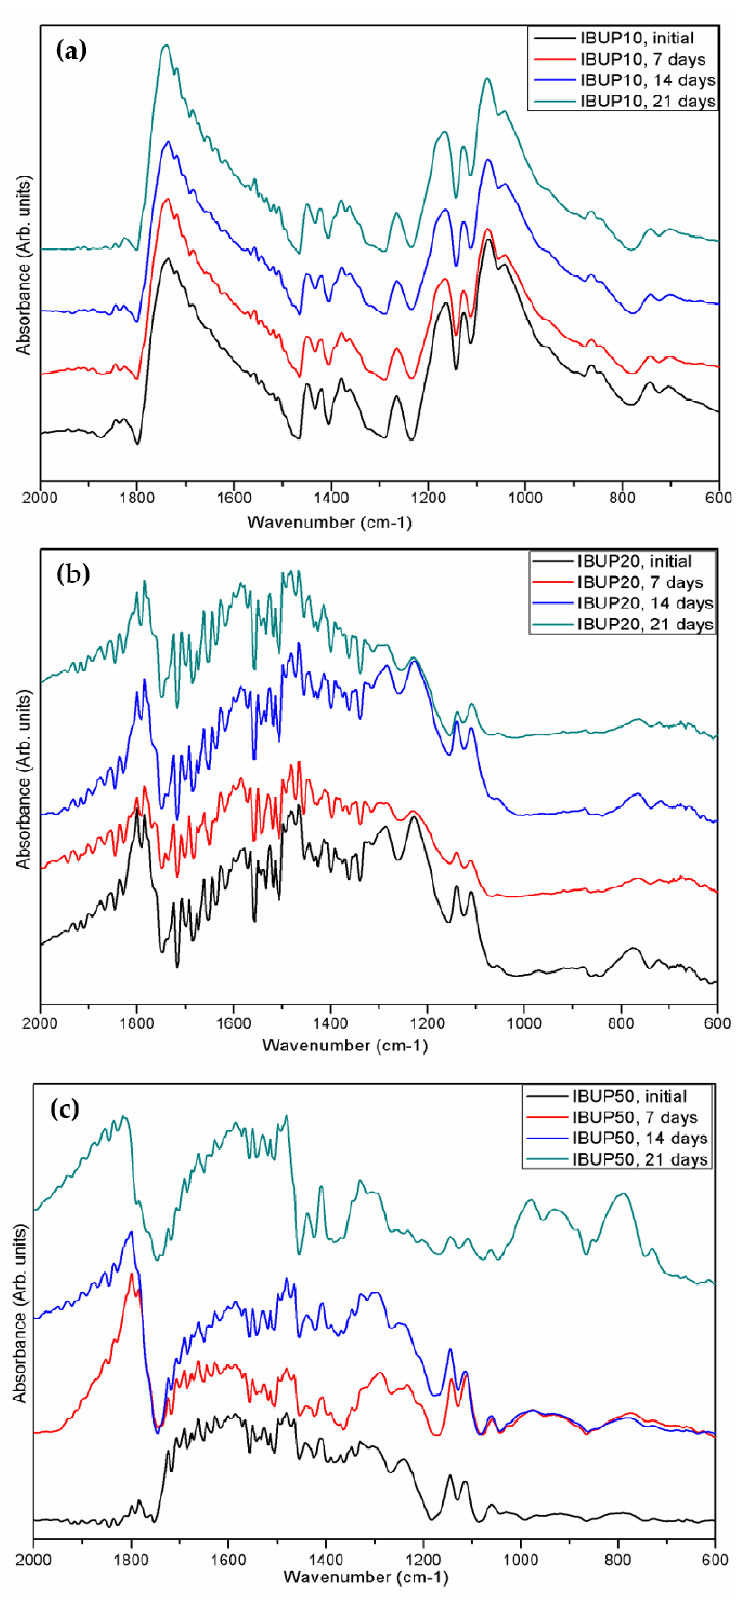
Figure 3. IR spectra of ( a ) IBUP10, ( b ) IBUP20, and ( c ) IBUP50 biopolymeric spheres before and after dynamic tests.